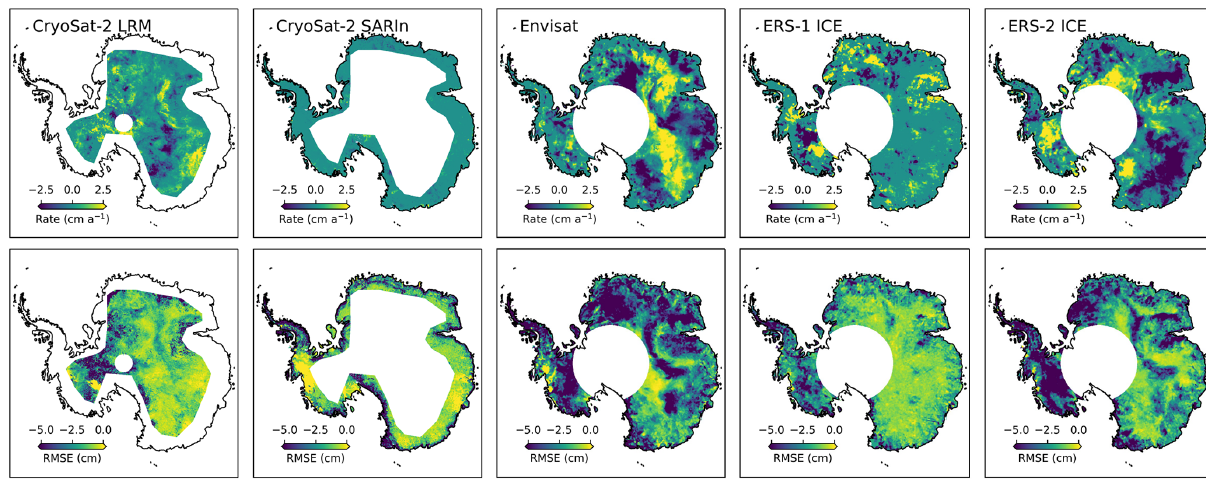
Figure 3. Change in elevation change rate and RMSE (seasonal amplitude) of the local time series after correction for temporal changes in scattering (penetration depth). Spatial patterns linked to surface conditions can be clearly observed. These effects are most prominent for Envisat and